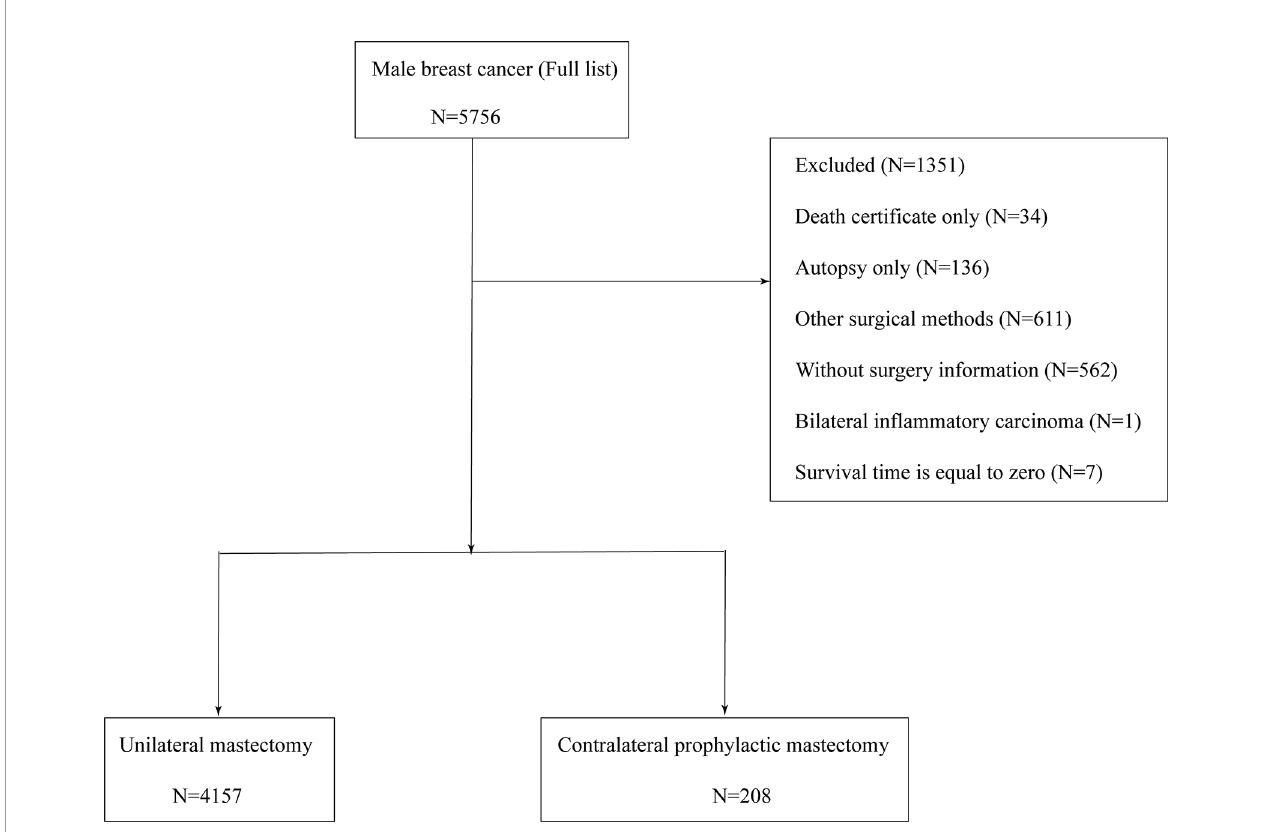
FIGURE 1 | Eligibility, inclusion, and exclusion criteria of study